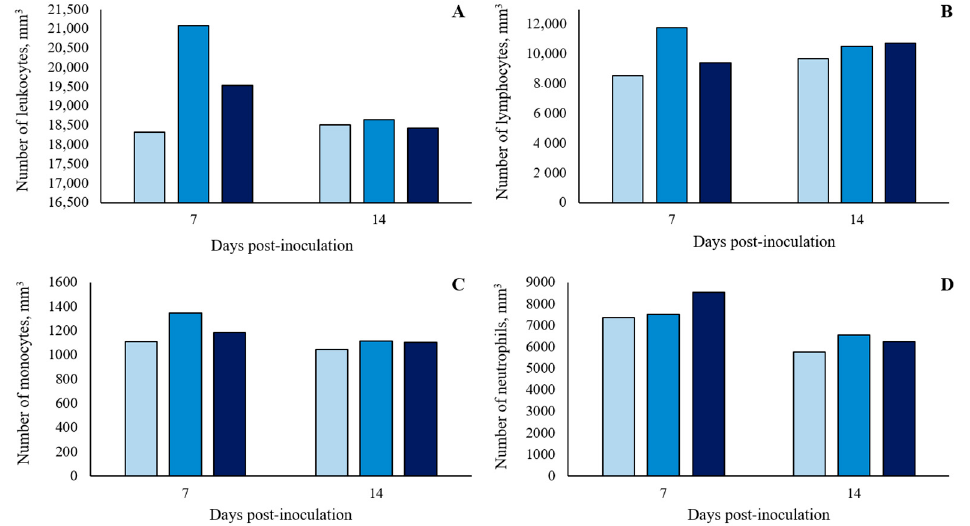
Figure 4. Number of leukocytes ( A ), lymphocytes ( B ), monocytes ( C ) and neutrophils ( D ) of growing pigs orally challenged or not with Salmonella Typhimurium. ( ■ ) Pigs without Salmonella Typhimurium challenge (Basal); ( ■ ) Pigs orally challenged with 1 × 10 8 CFU of Salmonella Typhimurium; ( ■ ) Pigs orally challenged with 1.5 × 10 8 CFU of Salmonella Typhimurium. No differences between treatments were observed by Tukey’s test ( p > 0.05).